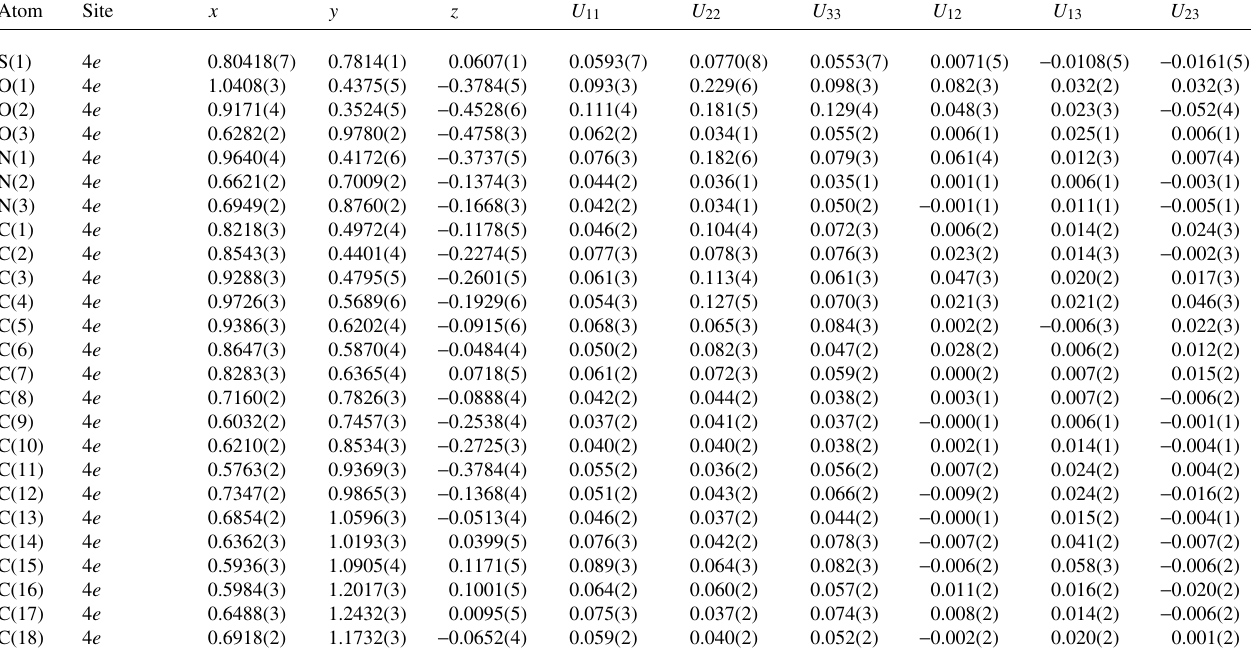
Table 3. Atomic coordinates and displacement parameters (in Å 2 ) .